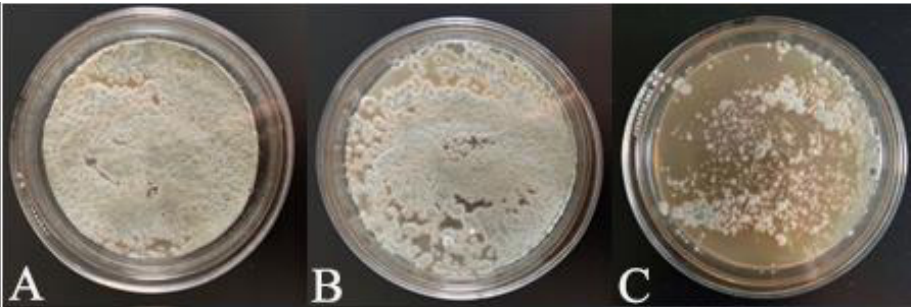
Table 1. Antifungal activity of Lycium barbarum leaf extract.